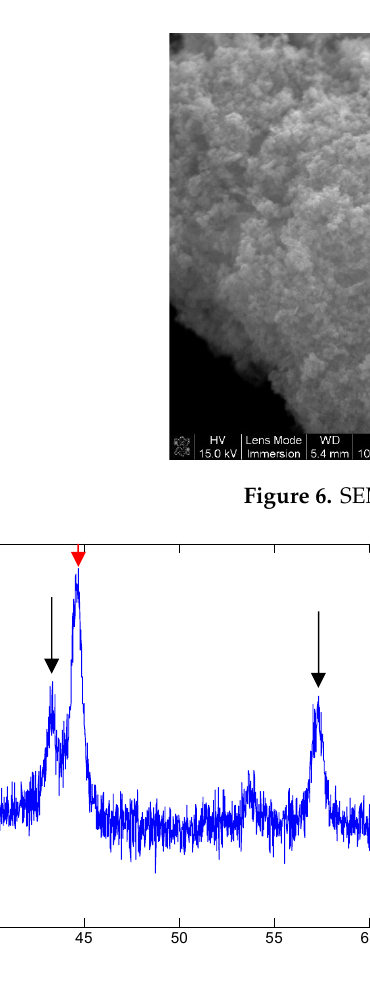
Figure 7. XRD of the FeNPs showing the peaks associated with the Fe (red arrows) and iron oxides (black arrows) present on the FeNPs.